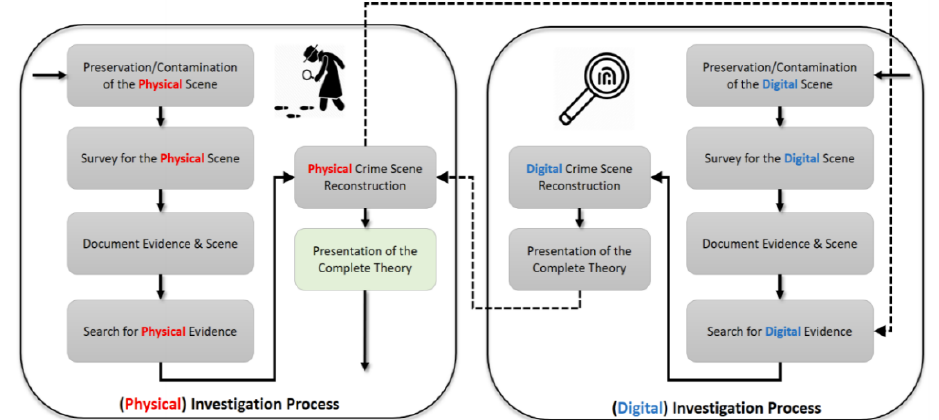
Figure 2. Physical and digital investigation constructs.